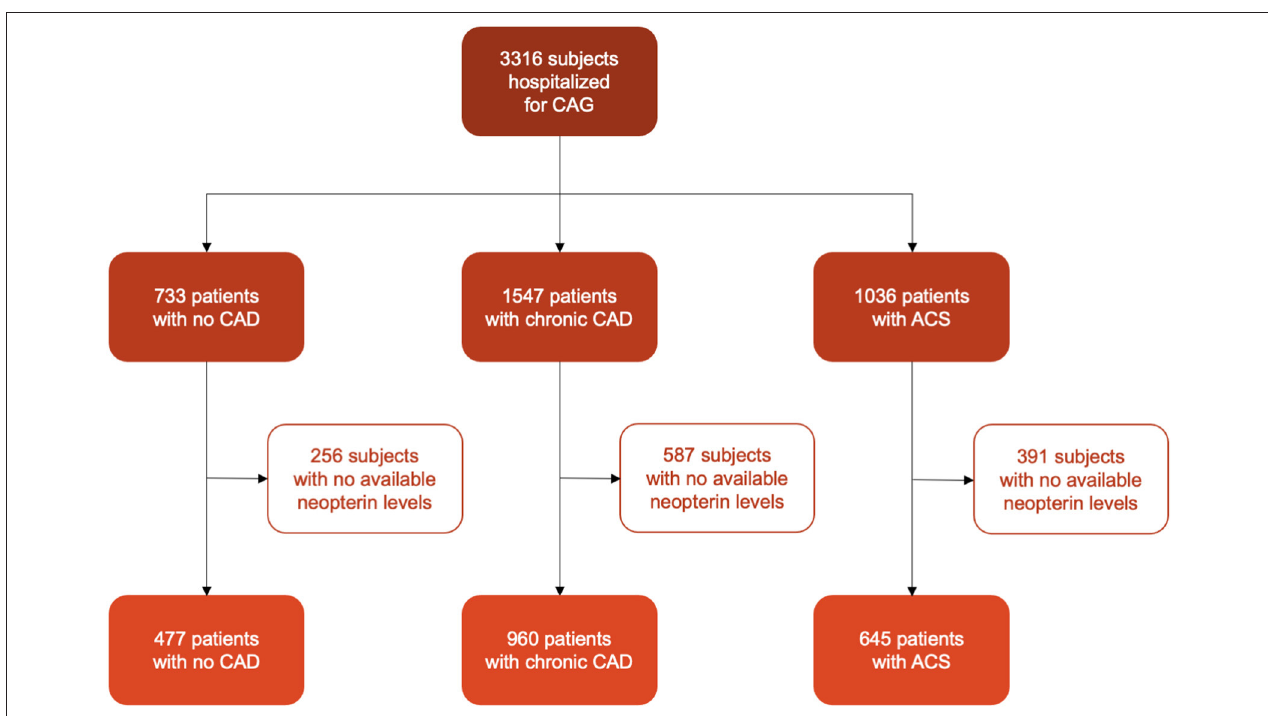
FIGURE 1 | Flowchart of patients’